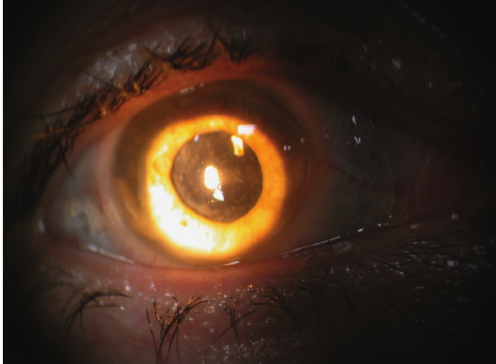
Figure 2: Pseudophakia, secondary cataract, and anterior granulo- matous uveitis in MS (left eye).